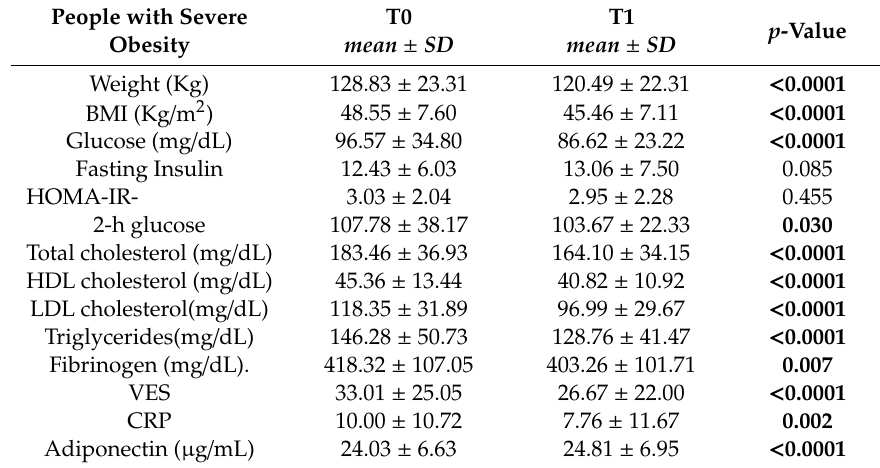
Table 2. Comparison of general and biochemical parameters of the people with severe obesity at baseline (T0) and at the end of a 4-week Hypocaloric diet and Physical exercise Program (HPP)